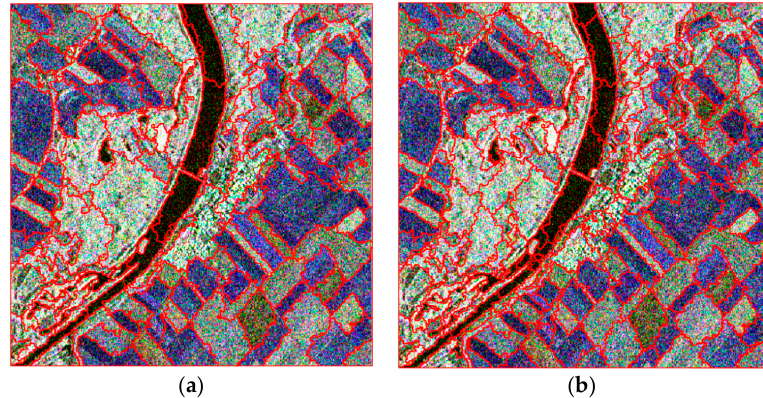
Figure 10. Segmentation results of the six-look TerraSAR-X PolSAR image using the proposed method: ( a ) IFGS, t = 16, w shp = 0.05, g 2 = 16; ( b ) IFGS, t = 12, w shp = 0.05, g 2 =